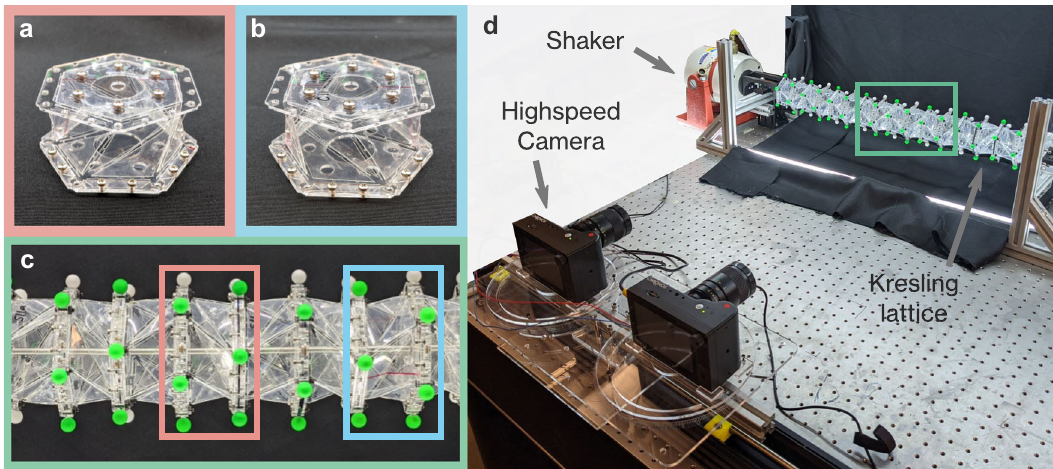
Fig. 6 Unit cell prototype and the experimental set-up of the chirp signal vibration test. Unit cells with a positive chirality and b negative chirality are assembled into c the dimer chain. d The dimer chain is mounted through the stainless steel shaft, connected to the shaker. A pair of high-speed cameras capture the left half and the right half of the chain behavior. Green spherical markers are tracked using the digital image correlation technique, to extract the horizontal and vertical motion of the polygonal